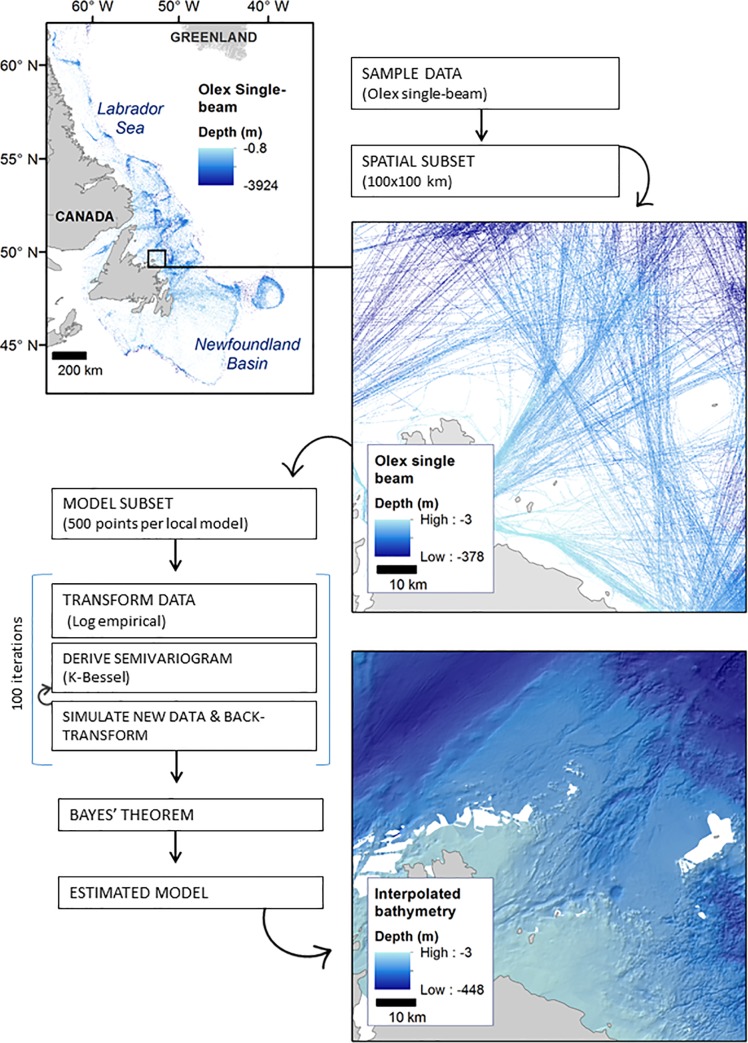
Conceptual diagram of the Empirical Bayesian Kriging process as employed in ArcGIS Pro 2.0.